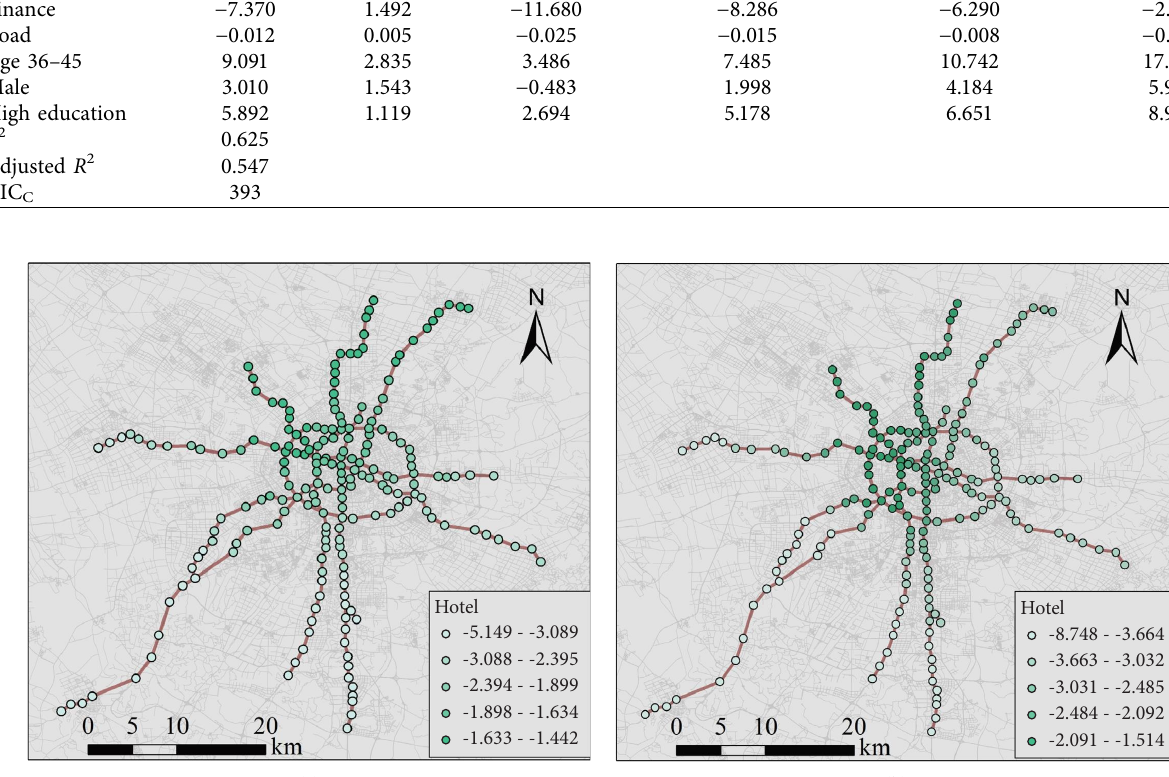
Figure 6: Spatially varying efects of a hotel on the access/egress distance. (a) Efects of the hotel on the access distance and (b) efects of the hotel on the egress distance.